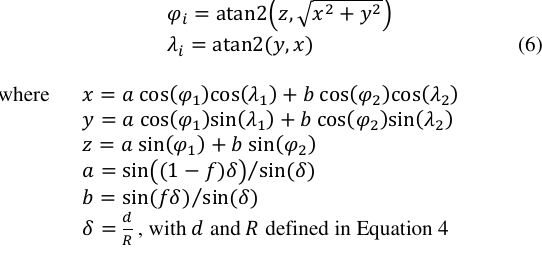
Quaternions representing rotation from the sensor system to ECF are computed from each set of unit vectors computed via Equation 7 and assembled into a time history of attitude